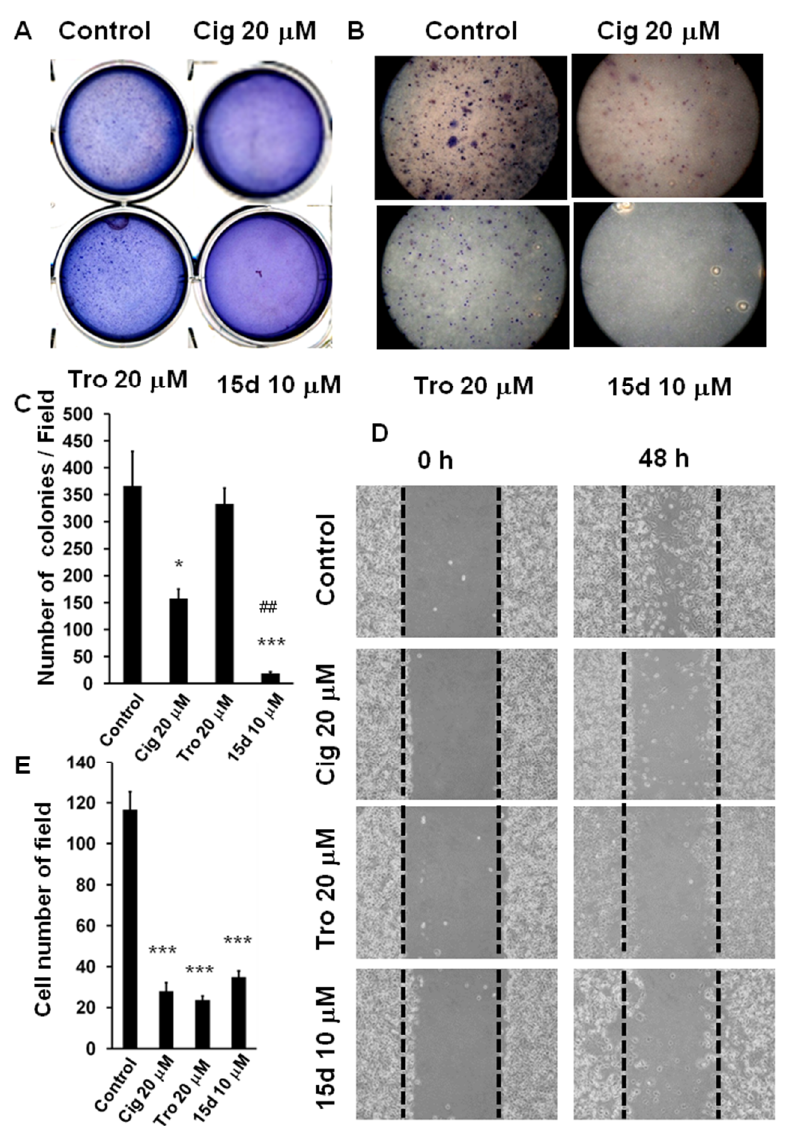
Figure 1. Arrest of glioma tumor growth and migration by PPAR γ agonist. U87 were seeded at 2 × 10 4 cells/mL in soft agar and treated with PPAR γ agonists, ciglitazone 20 µ M, troglitazone 20 µ M, or 15d-PGJ2 10 µ M. Colony staining was performed with 0.04% Giemsa solution at day 21. Measurement of U87 cells migration by several PPAR γ agonists assessed in wound healing assay with U87 cells seeded at 2 × 10 5 cells/mL and treated with different PPAR γ agonists. ( A ) Representative U87 growth pattern in soft agar treated in different PPAR γ agonists. ( B ) Giemsa staining of U87 cell colonies treated in different PPAR γ agonists under 100 × magnification ( C ) Quanti- tative analysis of colony formation in different treatment groups repeated with three independent tests. ( D ) The photography of wound healing test treated with different PPAR γ agonists including ciglitazon, troglitazone, and 15d-PGJ2 at the 5 µ M taken under 100 × magnification and repeated in three independent tests. ( E ) Quantitative analysis of number of cells in each field for different treatment groups. *: p < 0.05; ***: p < 0.001 indicated the experiment relative to control. ##: p < 0.01 indicated the experimental group (15d-PGJ2) relative to another experimental group (troglitazone). Subcutaneous injections of U87 cells at an amount of 5 × 10 6 cells were assessed when the tumor had grown to 5 mm in diameter. That was used as the baseline for further comparisons. The intratumor injection of 2 mg/kg ciglitazone or 2 mg/kg